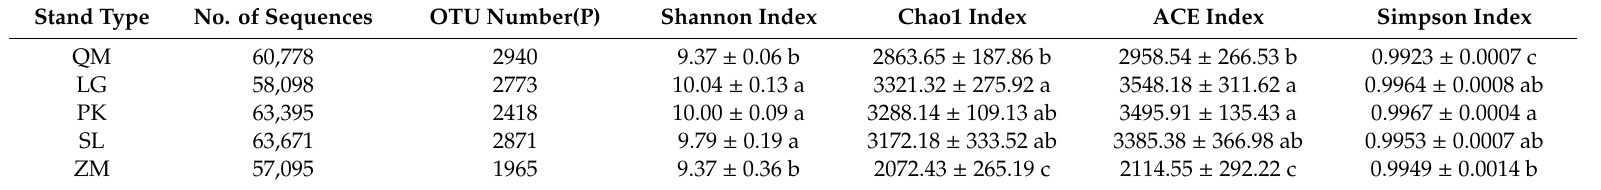
Table 3. Soil bacterial diversity indices of soils with di ff erent land use types.